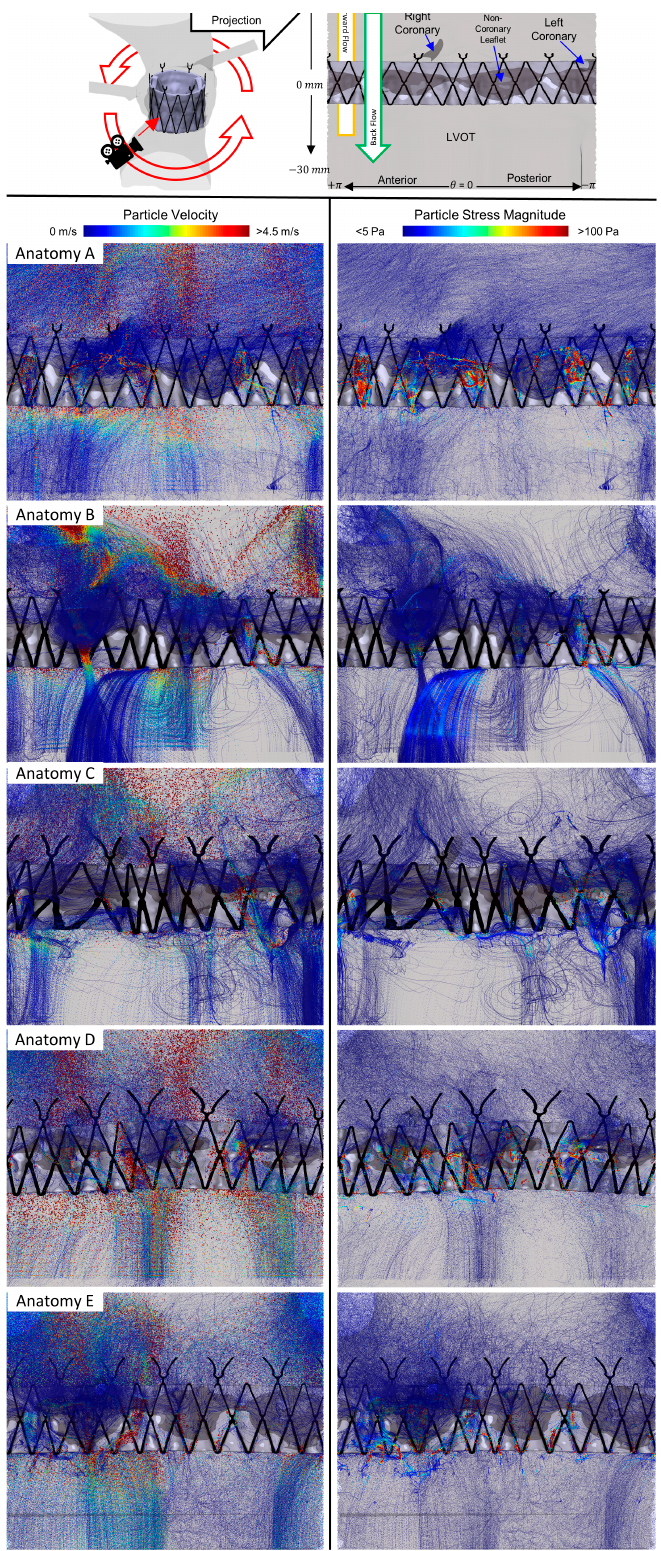
Figure 4. Polar projections of pathlines of the top 3000 highest SA platelets—Top—key to visualize the polar projection with red arrow demonstrating projection angle. From top to bottom are each of the patient-specific anatomies A–E. Left-column platelets are colored and sized according to the velocity magnitude, while right-column platelets are colored by stress